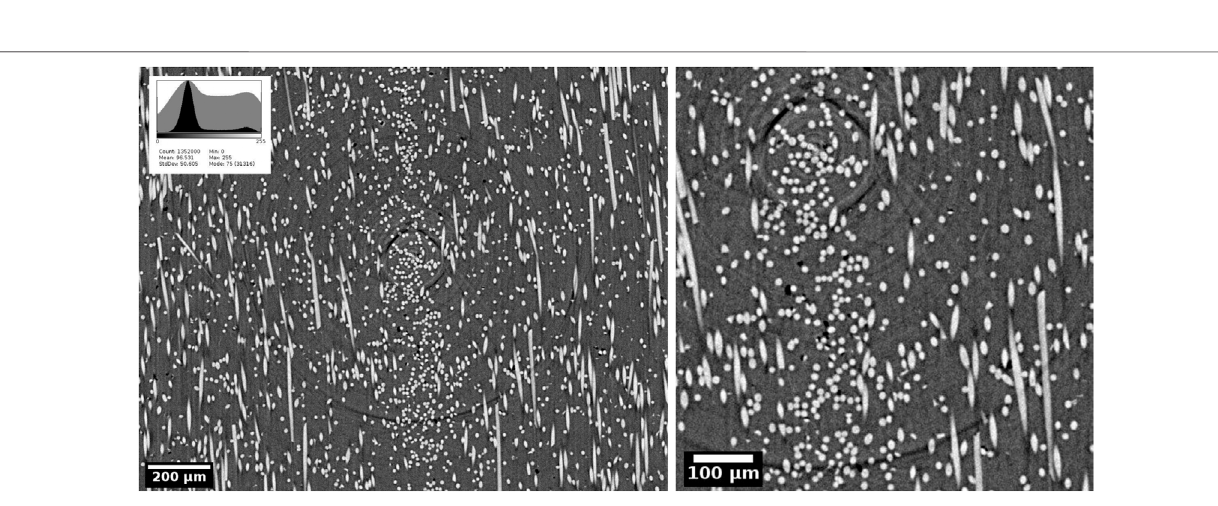
Frontiers in Materials |